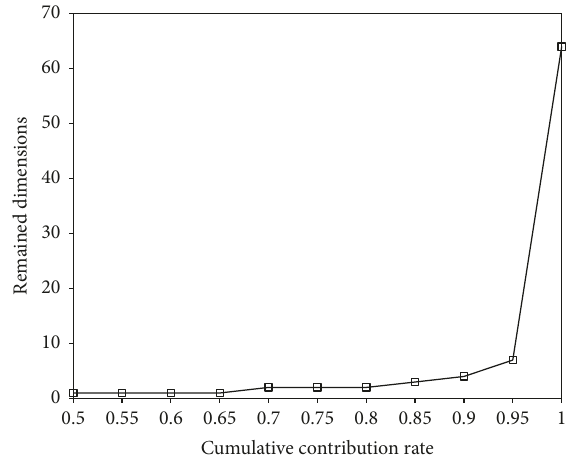
Figure 3: Remaining dimension for di ff erent cumulative contribution rates.